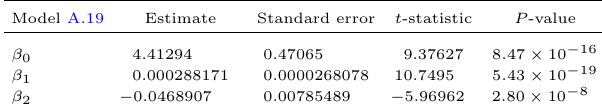
Table A.9. Regression results for model A.19.